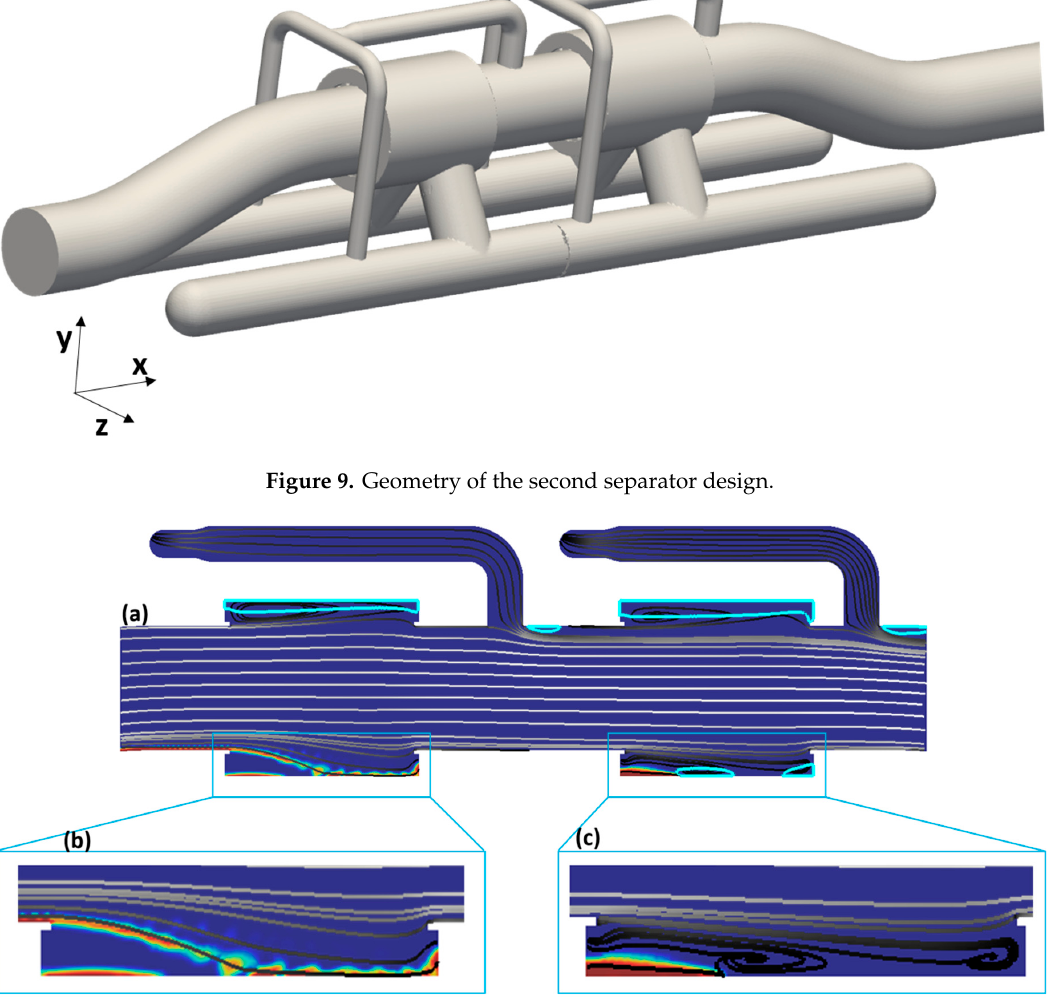
Figure 9. Geometry of the second separator design.